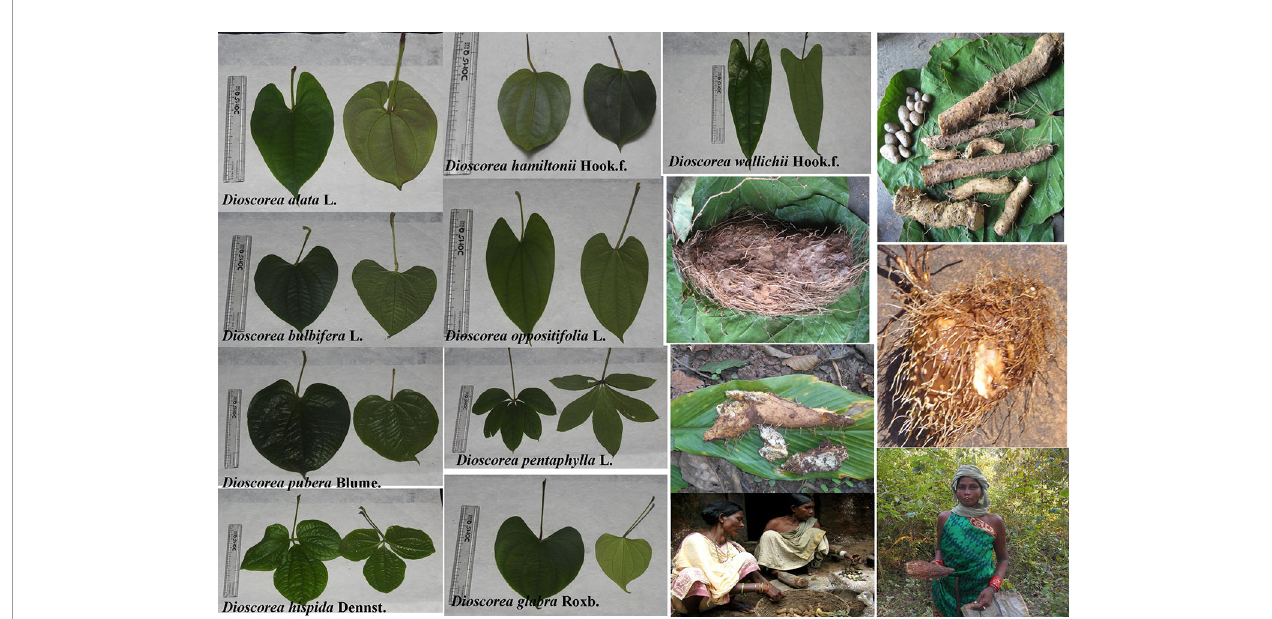
FIGURE 1 | Morphological variations of different Dioscorea species consumed by the tribal